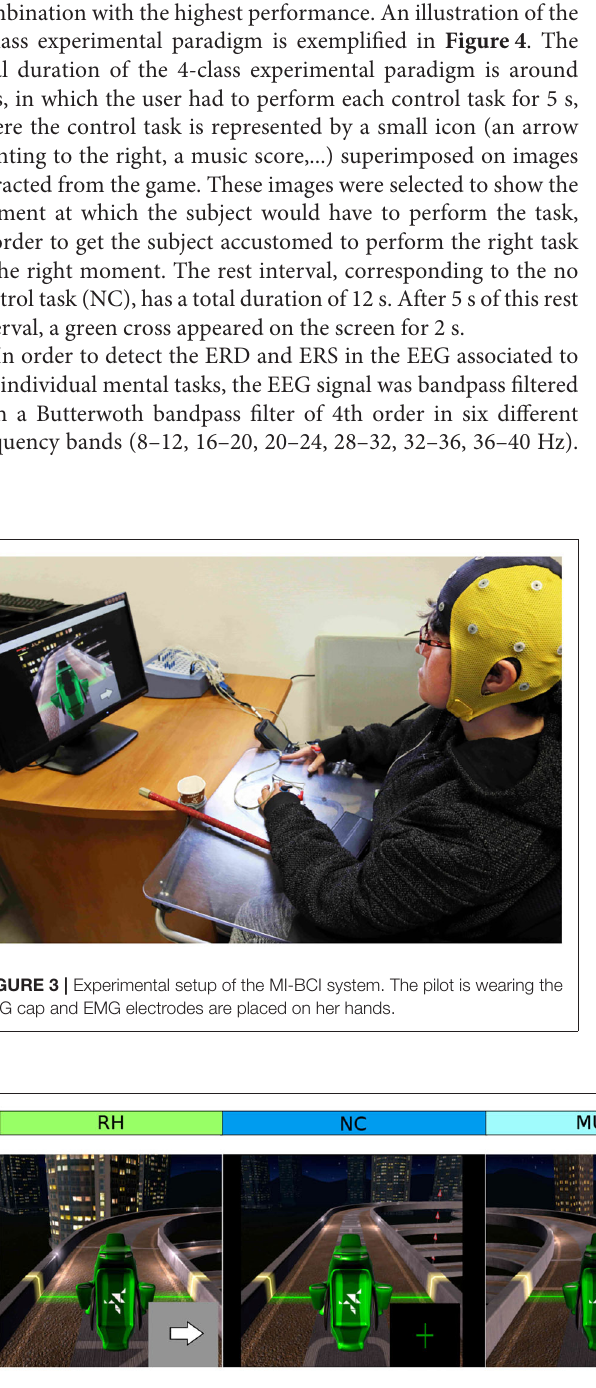
Frontiers in Human Neuroscience |